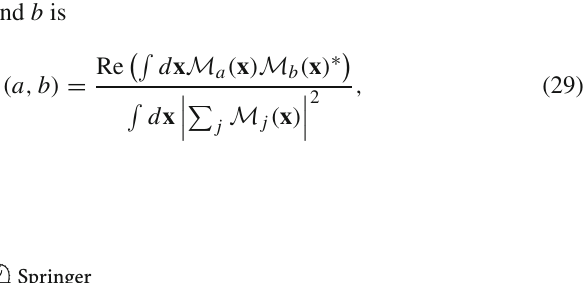
Fig. 6 Distributionsforsixinvariant-massobservablesintheRSdecay D 0 → K − π + π + π − . Bands indicate the expectation from a model which excludes the decay chain K 1 ( 1270 ) − → ρ( 1450 ) 0 K − , with the